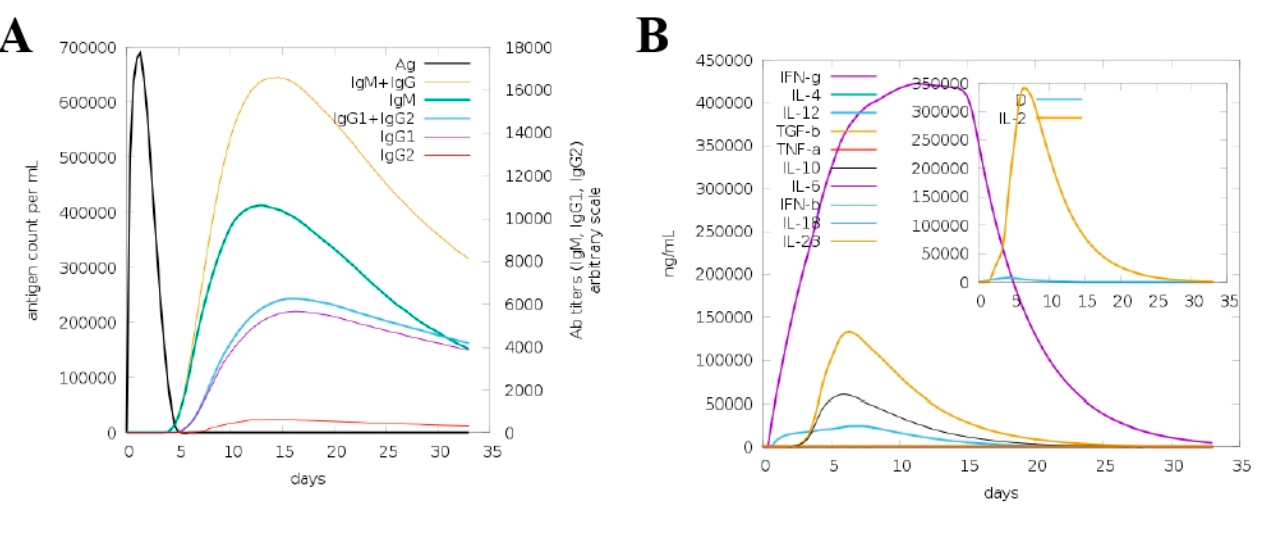
Figure 11. Different immune responses towards (MEV) against E. hormaechei. ( A ). Antibodies titer and ( B ) interferon and cytokines responses to the vaccine.